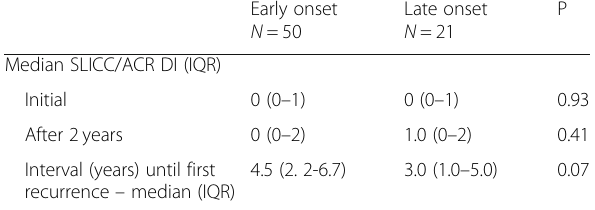
have silent activity only disclosed by repeated biopsy